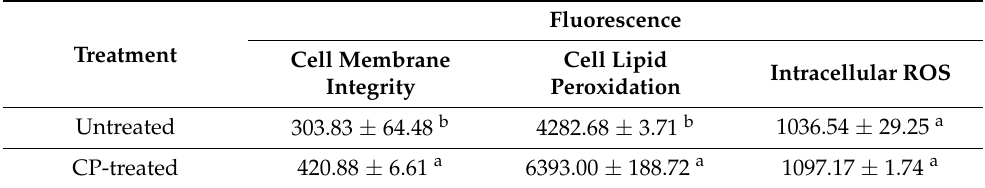
Table 3. Changes in cell membrane integrity, lipid peroxidation, and intracellular reactive oxygen species (ROS) levels before and after in-package cold plasma (CP)